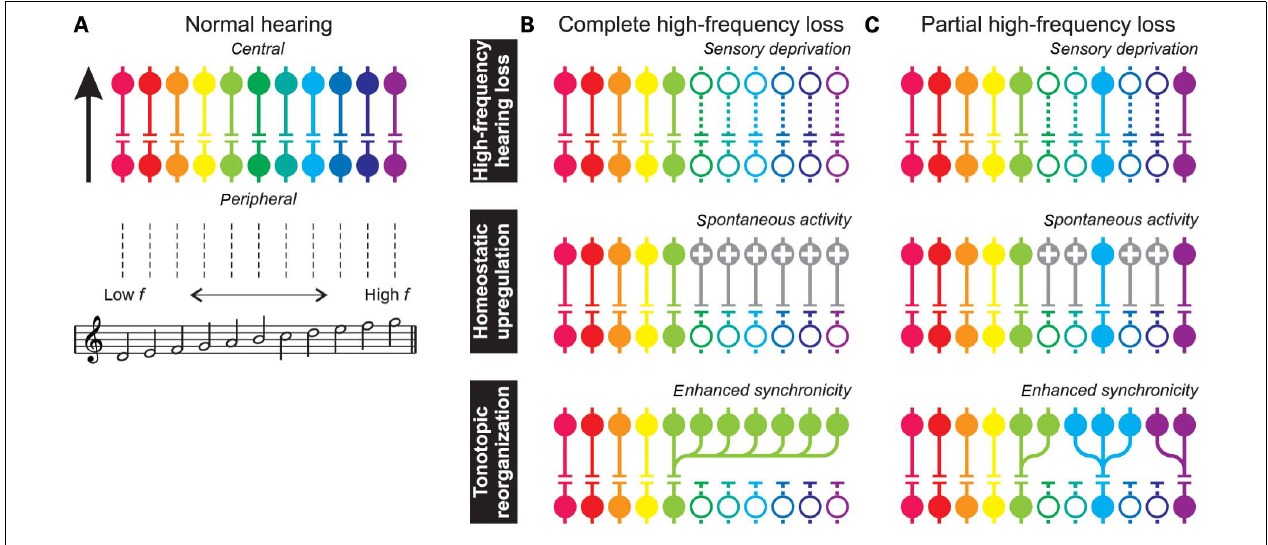
(bottom panel), large numbers of neurons receive input from the edge-frequency region. (C) In the present study, high-frequency hearing thresholds were largely normal, suggesting that sufficient hair cells and neurons in the affected frequency regions remained intact. Homeostatic upregulation or tonotopic reorganization would then be limited to the interspersed deprived neurons only, but would still lead to elevated activity or enhanced synchronicity, respectively, resulting in the presence of a tinnitus